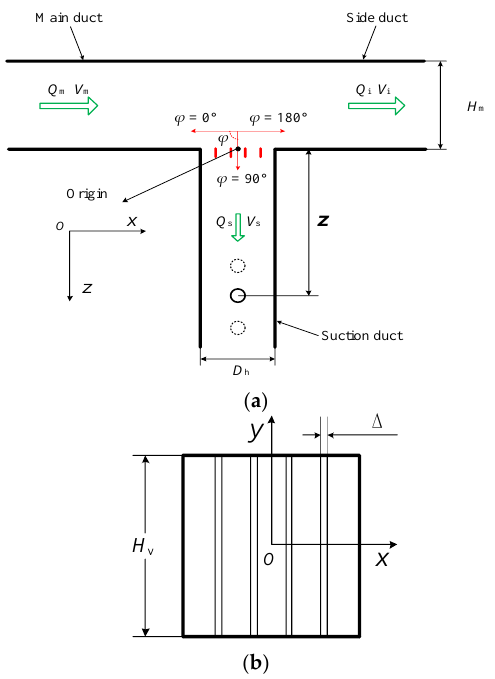
Figure 2. Schematic diagram of experimental test: ( 1 ) Entrance; ( 2 ) Transition section; ( 3 ) Contraction section; ( 4 ) Main duct; ( 5 ) Side duct; ( 6 ) Flow metering duct; ( 7 ) Expansion section; ( 8 ) Blower; ( 9 ) Test section; ( 10 ) Valve; ( 11 ) Rotor flowmeter; ( 12 ) Pitot tube; ( 13 ) Data acquisition system.